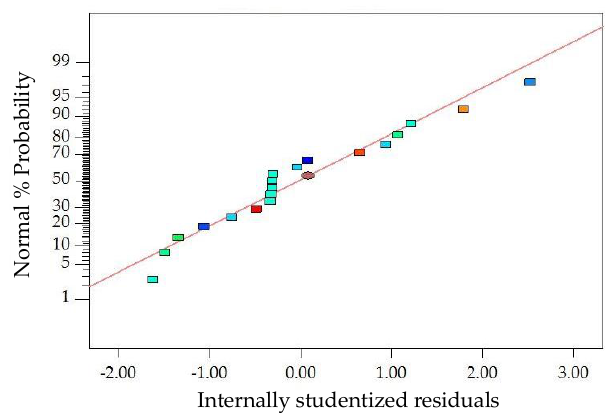
Figure 8. Diagnostics of statistical model: normal plot of residuals for FV .